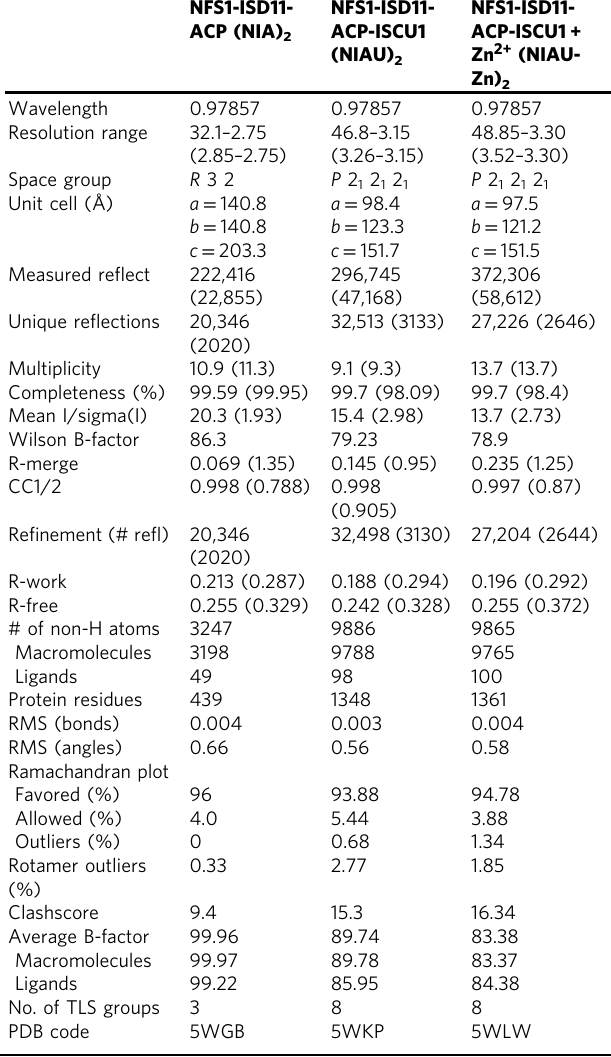
Table 1 X-Ray diffraction data and re fi nement